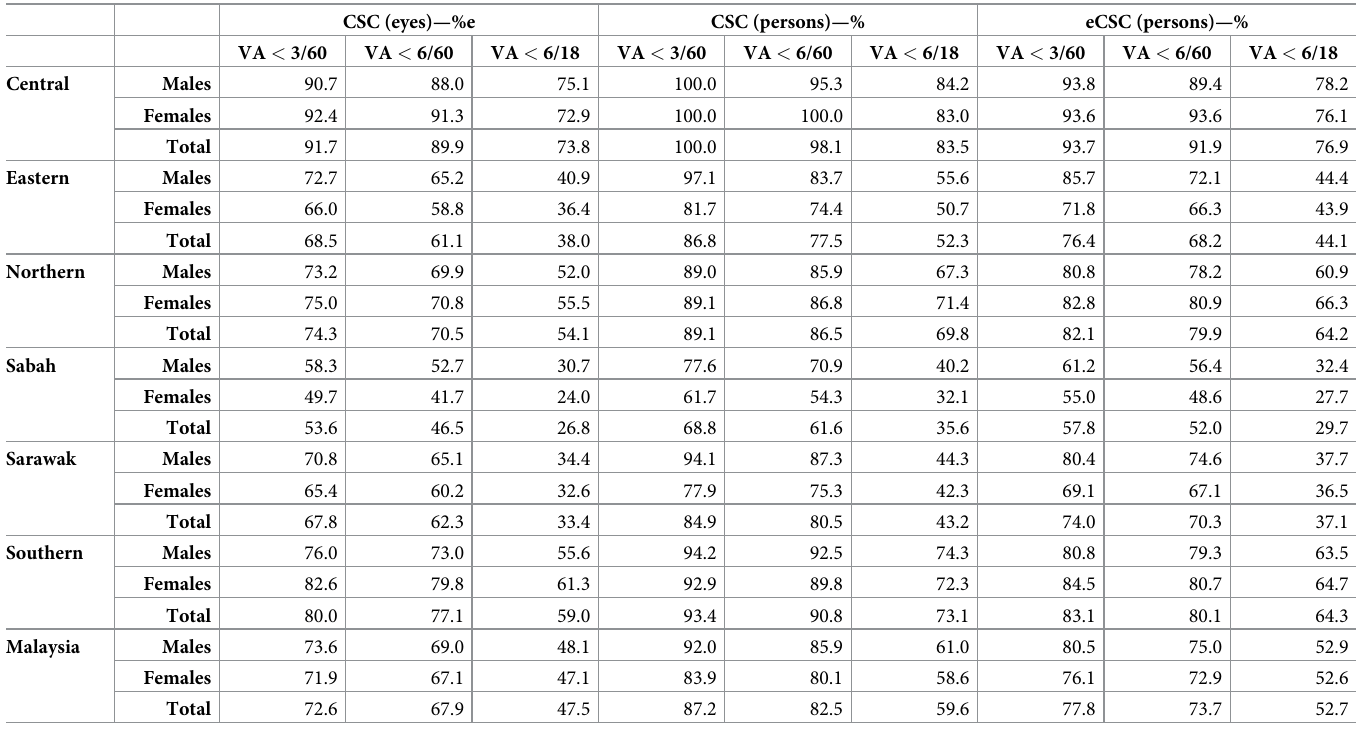
Table 4. Cataract surgical coverage (CSC) by person and eyes for sample population.